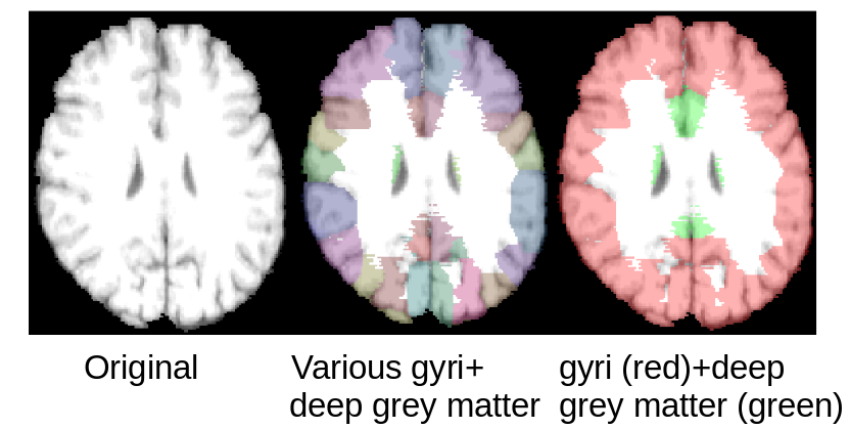
Figure 4. Selected slice from a MRI dataset from the LPBA40 database ( left ) with expert labels superimposed on the original slice ( middle ) and the fused labels used in this work ( right